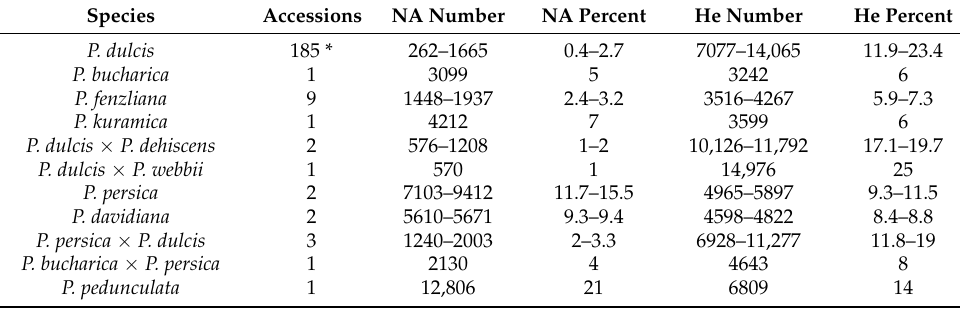
Table 3. Genotyping results of some Prunus species and interspecific hybrid accessions with the almond array. (NA: Missing data, He: